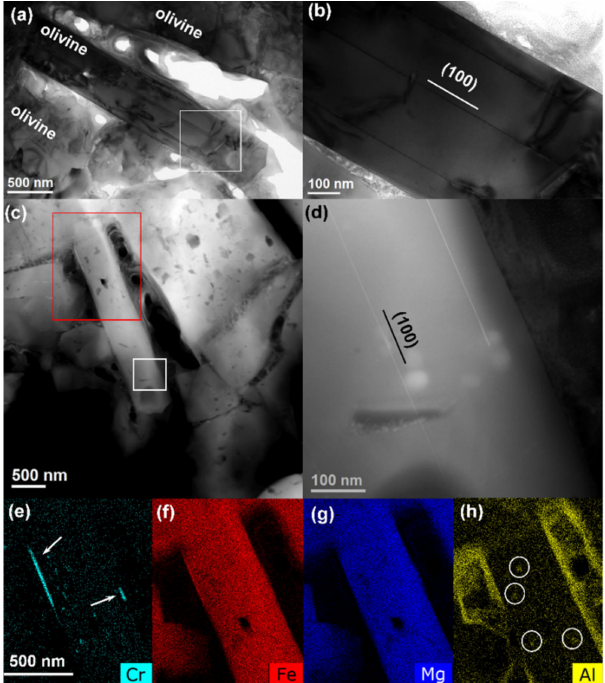
Figure 1. ( a ) Bright-field TEM image at low magnification showing olivine grains cemented by a poorly crystallized silicate groundmass. Note the elongated shape of the olivine grains. ( b ) Magnified view corresponding to the white rectangular box in ( a ). The olivine grains contain frequent thin planar defects parallel to the (100) planes. ( c ) HAADF image of an elongated olivine grain in the matrix. ( d ) HAADF magnified view according to the white rectangle in ( c ) showing that thin planar defects display high Z contrast. ( e – h ) STEM-EDX maps of respectively Cr, Fe, Mg, and Al of the area marked by red rectangle in ( c ). The olivine contains numerous low-Z contrast inclusions consisting of Al-rich spinel (indicated with circles in the EDX map in ( h ), voids, and frequent C-rich material. White arrows in ( e ) highlight Cr-rich thin platelets that locally cover the olivine